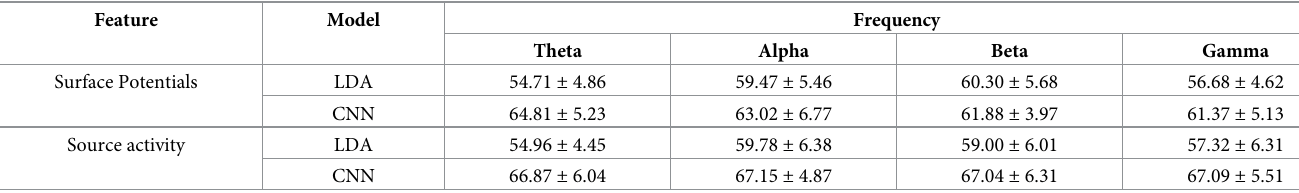
Table 1. AUC (%) for pre-stimulus segments.